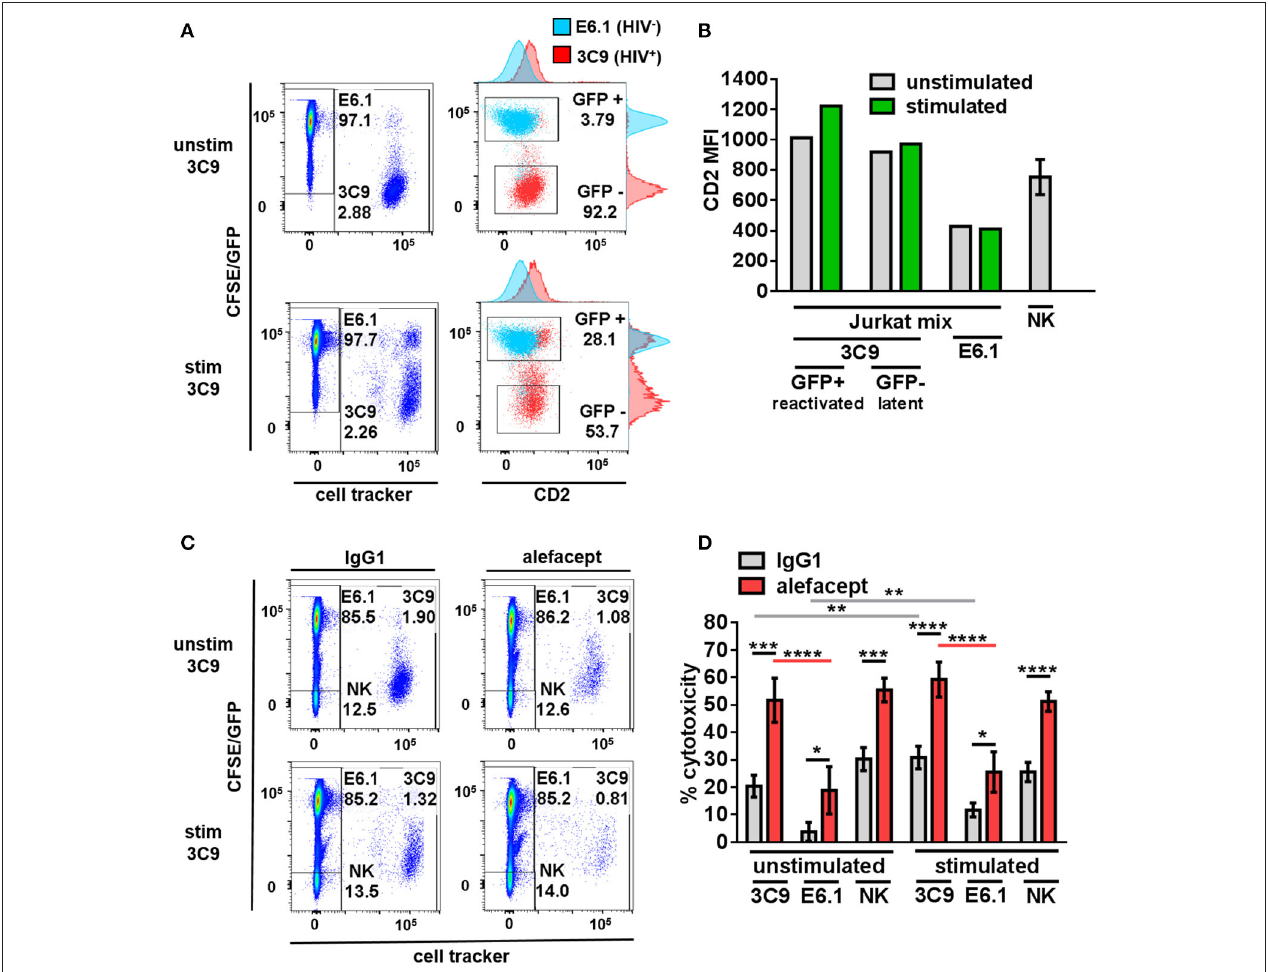
FIGURE 1 | Primary NK cells selectively target HIV + 3C9 Jurkat for killing by ADCC with alefacept more than HIV − E6.1 in Jurkat mix. (A) Flow cytometry plots of Jurkat mix. Deep red cell tracker labeled HIV + 3C9 was diluted 1:100 with CFSE labeled uninfected E6.1 parent Jurkat cell line. 3C9 Jurkat was either unstimulated or pre-stimulated with 1ng/mL TNF α before mixing with E6.1 Jurkat to induce expression of GFP-HIV. (B) Experimental representative of quantification of CD2 MFI on Jurkat cells and n = 6 primary NK cell donors. (C) Flow cytometry plots of representative donor primary NK cells and Jurkat mix killing assay with 10 µ g/mL IgG1 or alefacept. (D) Percent cytotoxicity of 3C9, E6.1 and primary NK cells with IgG1 control antibody or alefacept after co-culture as measured by absolute cell count flow cytometry with n = 6 primary NK cell donors with E:T = 0.1:1, after 19h in co-culture Mean and SEM shown for 6 primary NK cell donors, * P ≤ 0.05, ** P ≤ 0.01, *** P ≤ 0.001, **** P ≤ 0.0001. Statistical significance between IgG1 and alefacept conditions are indicated with black bars, statistical significance between cell types with IgG1 are indicated with gray bars and statistical significance between cell types with alefacept are indicated with red bars. Absolute CD2 MFI and relative MFI between cell types was consistent across experiments. One representative of 5 similar experiments is shown as the Jurkat cell lines are clonal.